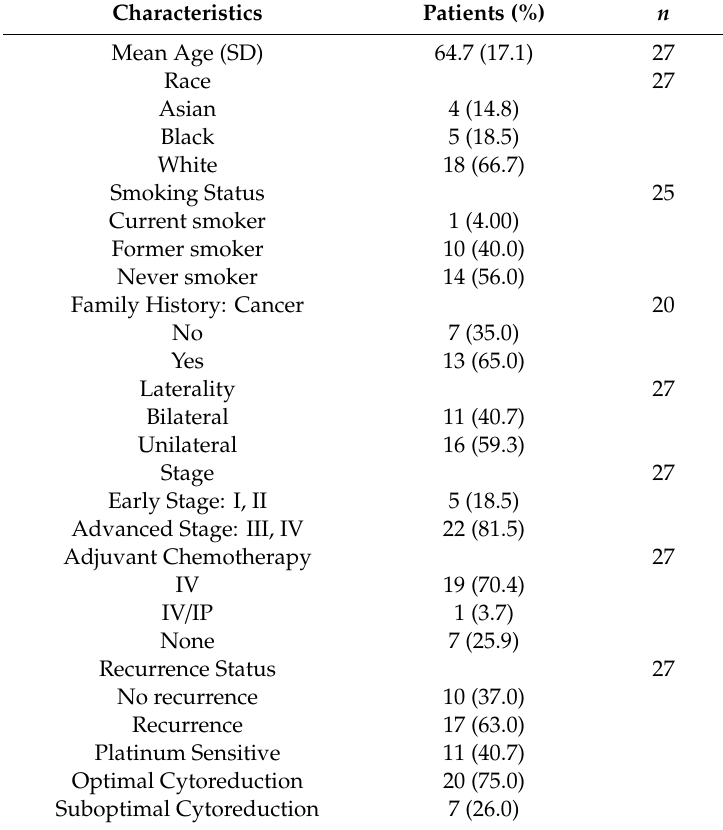
Table 1. Demographic